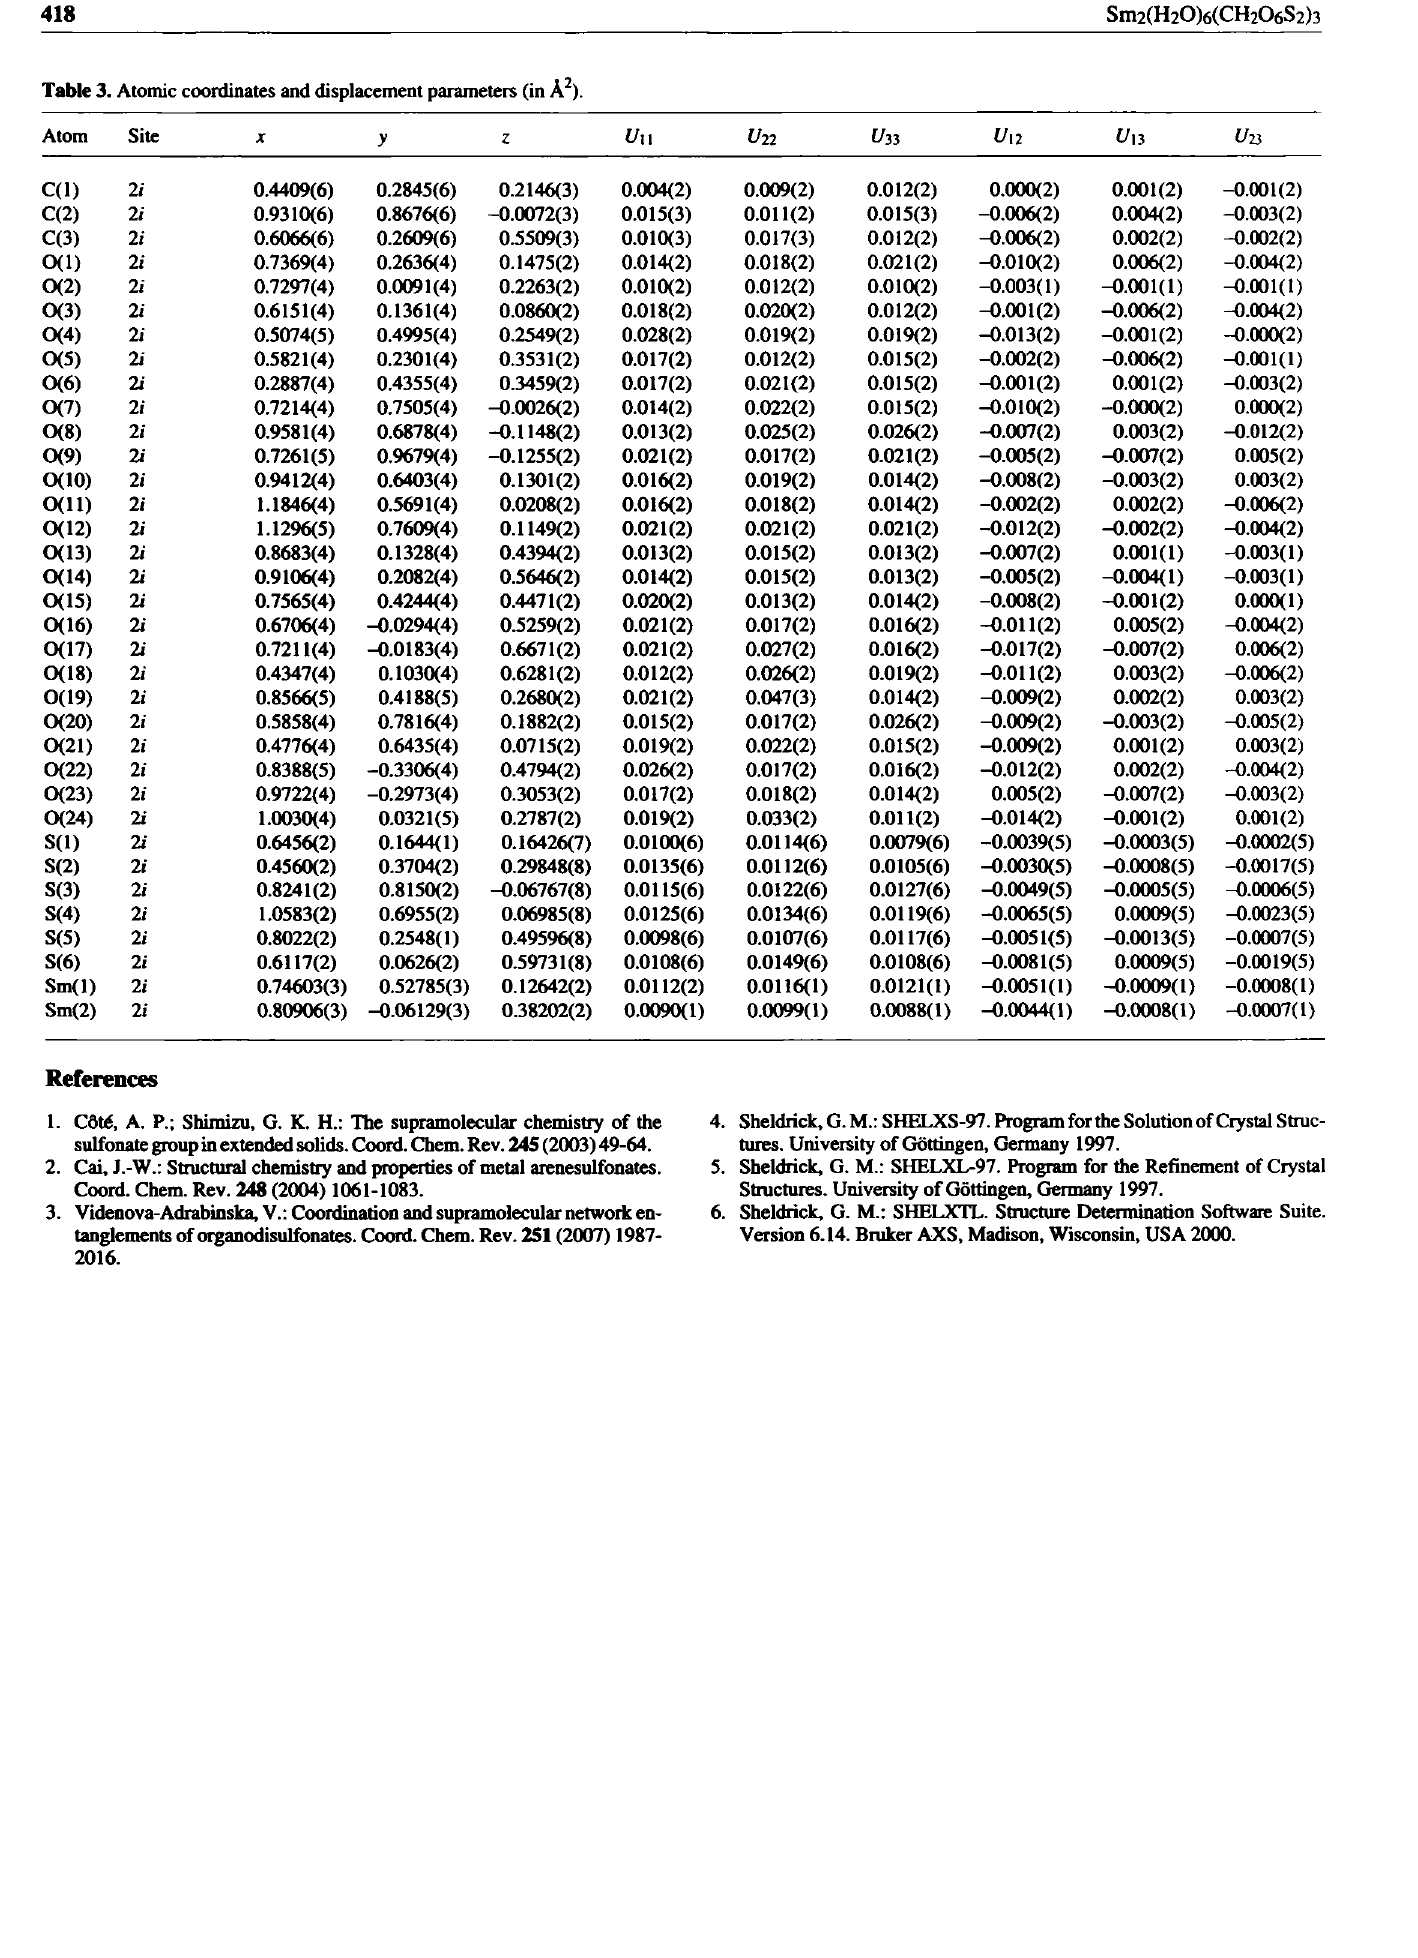
Table 3. Atomic coordinates and displacement parameters (in Ä 2